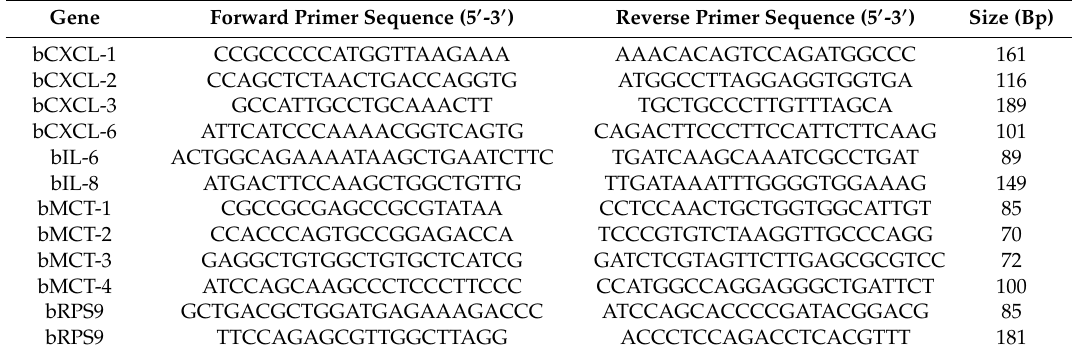
Table 1. Sequences of forward and reverse